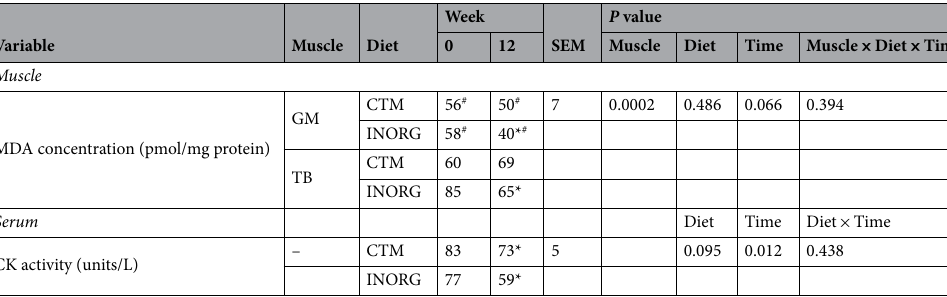
Table 1. Pre-trailer muscle malondialdehyde (MDA) concentrations in the gluteus medius (GM) and triceps brachii (TB) and serum creatine kinase (CK) activity at 0 and 12 weeks of submaximal exercise training in yearling horses supplemented with either complexed trace minerals (CTM; n = 8) or inorganic trace minerals (INORG; n = 8). *Within a row, mean differs from week 0 ( P ≤ 0.05). # Within a column, GM differs from TB ( P ≤